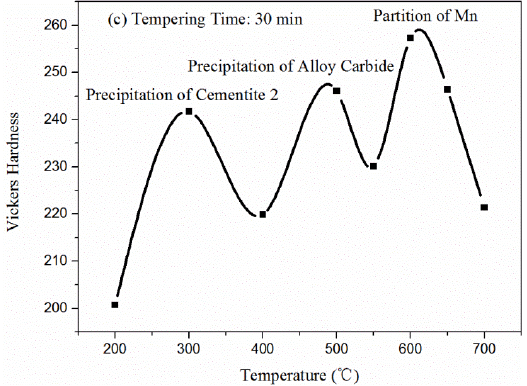
Figure 5. Hardness change of 700 L after tempering at different temperatures for 30 min.